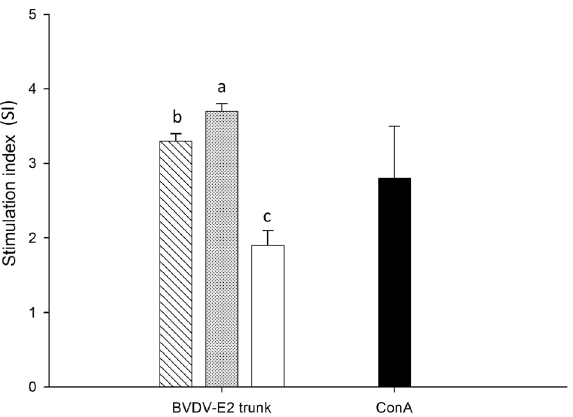
Figure 4. Stimulation of mice lymphocyte proliferation by truncated E2 glycoprotein. Stimulation index (SI) was calculated by dividing the mean OD value of stimulated wells by that of the control wells (media only). The data are presented as the mean ± standard deviations of three individual experiments. Treatments with different letters (a, b, c) on the bar indicate significant ( P < 0.05) differences. ( ) Group I: 5 μg of truncated E2 glycoprotein;( ) Group II: 35 μg of truncated E2 glycoprotein;( ) Group III: PBS;( ) Positive control: ConA.